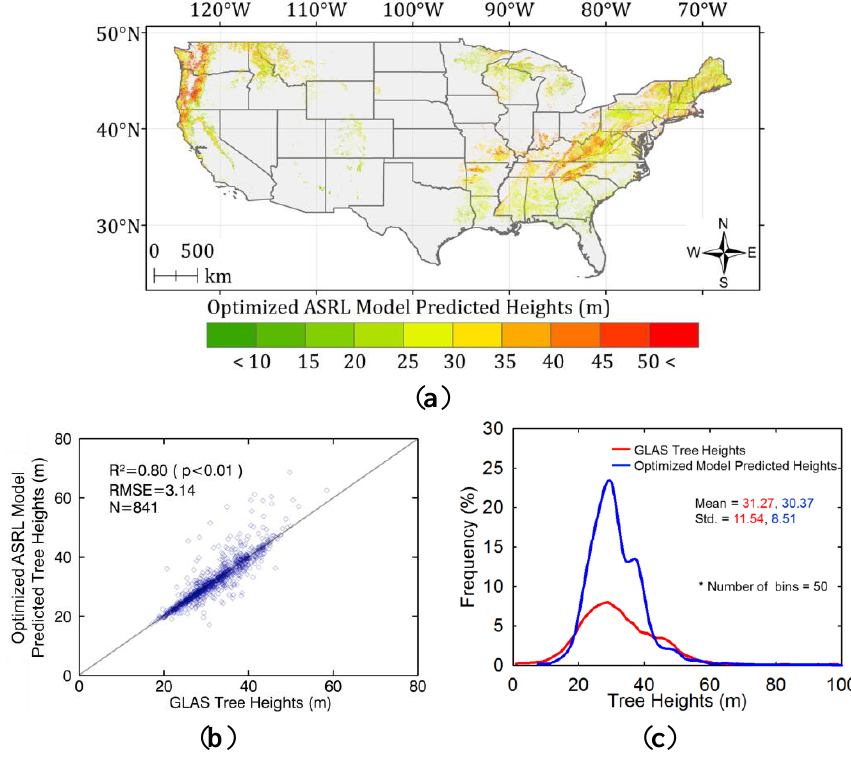
Figure 4. ( a ) Spatially continuous map of tree heights predicted by the optimized ASRL model at 1 km spatial resolution. ( b ) Comparison between GLAS tree heights and the optimized ASRL model predictions in each climatic zone. ( c ) Histograms at pixel level showing the degree of agreement between GLAS tree heights and the optimized ASRL model predictions. Number of bins of histograms is 50. Frequencies have been normalized by total grids (frequency